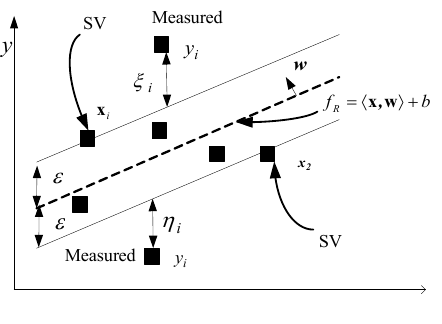
Figure 1. The slack variables and linear function of SVR.